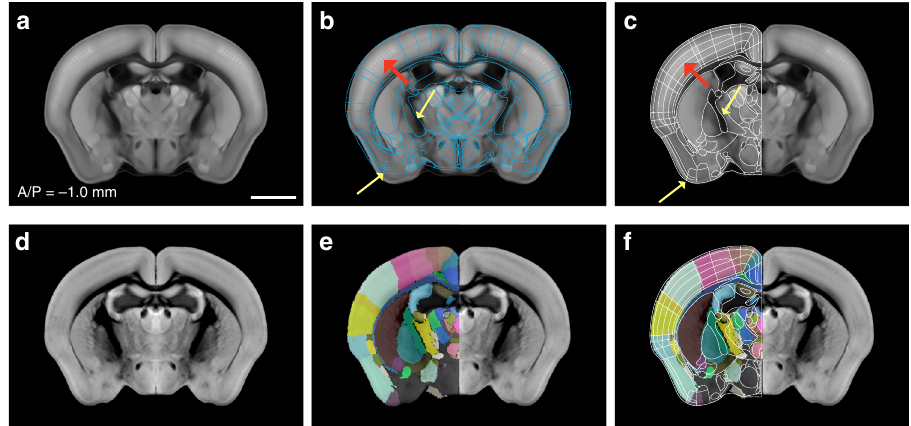
Fig. 1 Import and alignment of the FP labels onto the Allen CCF. a The Allen Common Coordinate Framework (CCF) that serves as base anatomical platform. A/P represent Bregma anterior/posterior coordinates. b Initial import of the Franklin-Paxinos (FP) vector labels into the Allen CCF. c Manual alignment based on anatomical features in the Allen CCF. Yellow arrows highlight distinct anatomical boundaries based on edges and white matter tracks. Red arrows indicate layer 4 in the somatosensory barrel cortex. d MRI images registered to the same CCF plane in ( a ). e Original FP based labels drawn in the MRI atlas registered to the Allen CCF. The lack of labels in the hypothalamic and amygdala regions are due to missing labels in the original MRI annotation. f Further adjustment of FP based anatomical delineation (white lines) based on the MRI labels. Scale bar = 2